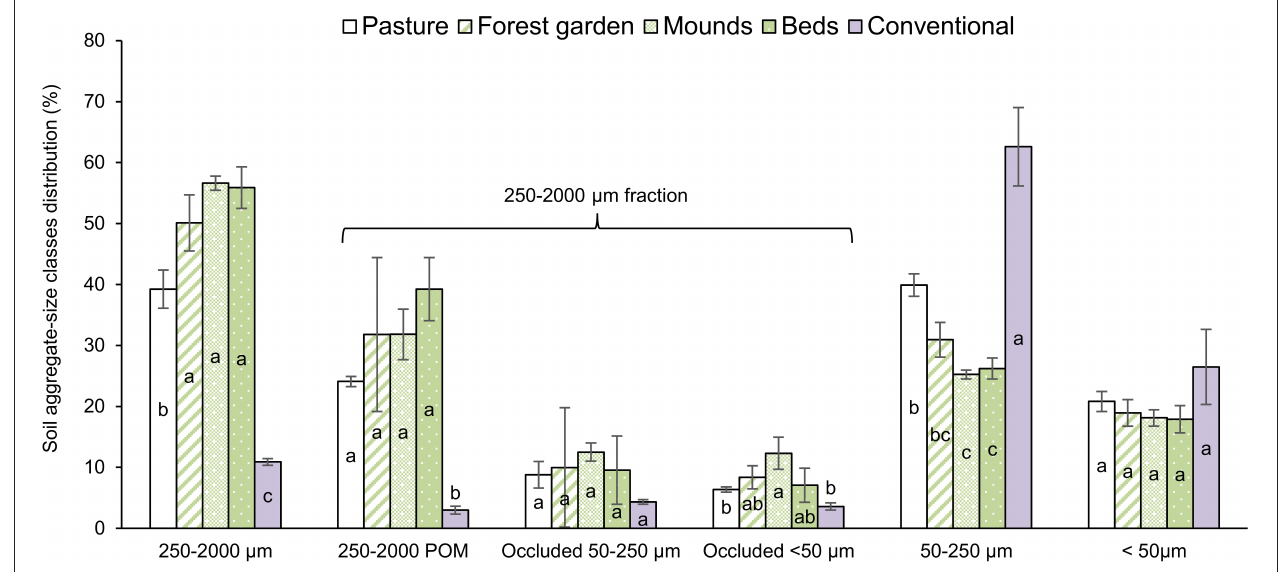
FIGURE 3 | Sand-free distribution of soil aggregate-size fractions in the bulk soils (%). White columns represent the pasture plot, green columns the permaculture plots and purple columns the conventional plot. Various letters represent significant differences at the 95% confidence level (LSD Tukey; n = 3). Bars indicate standard deviation of the mean.